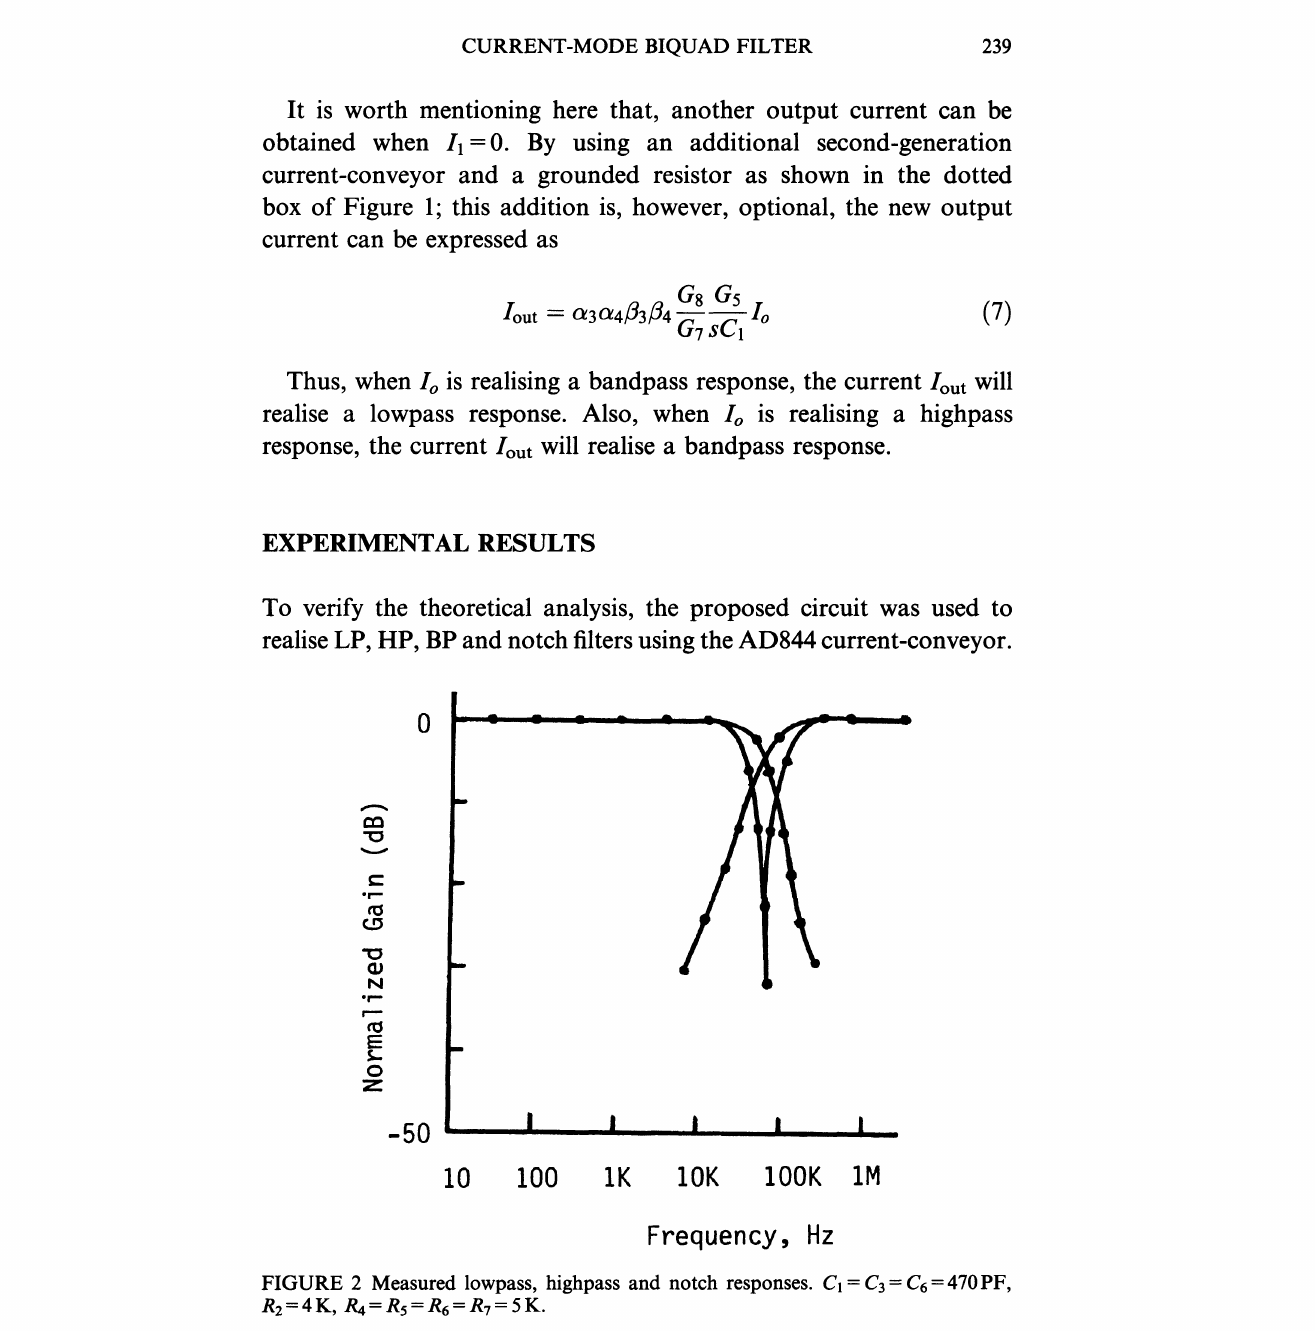
FIGURE 2 Measured lowpass, highpass and notch responses. C1 C3--C6=470 PF, R2=4K, R4= Rs= R6= RT= 5